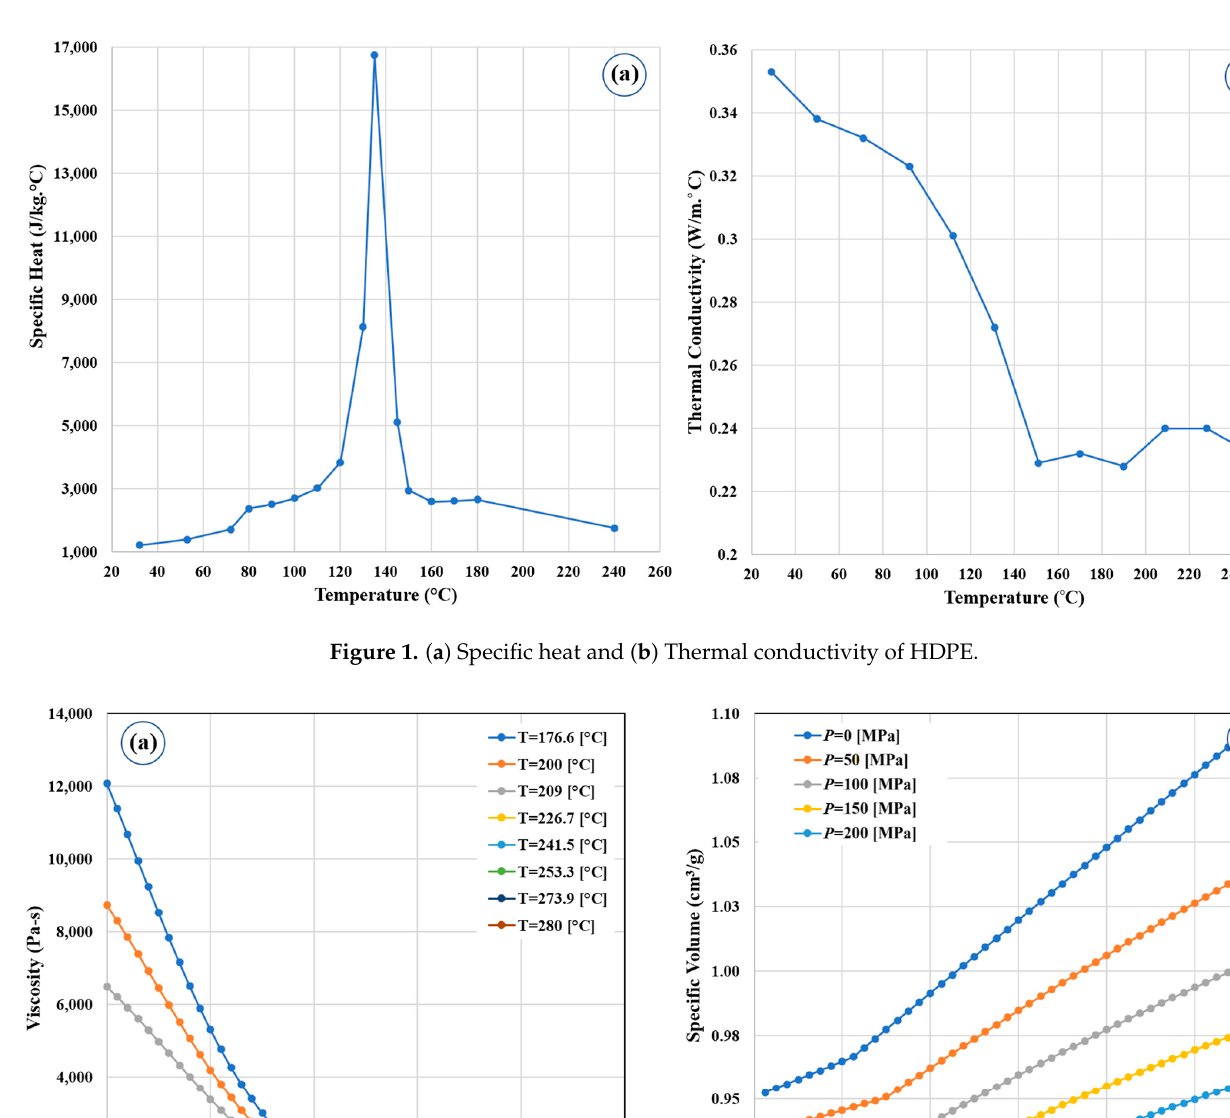
Figure 1. ( a ) Specific heat and ( b ) Thermal conductivity of HDPE.